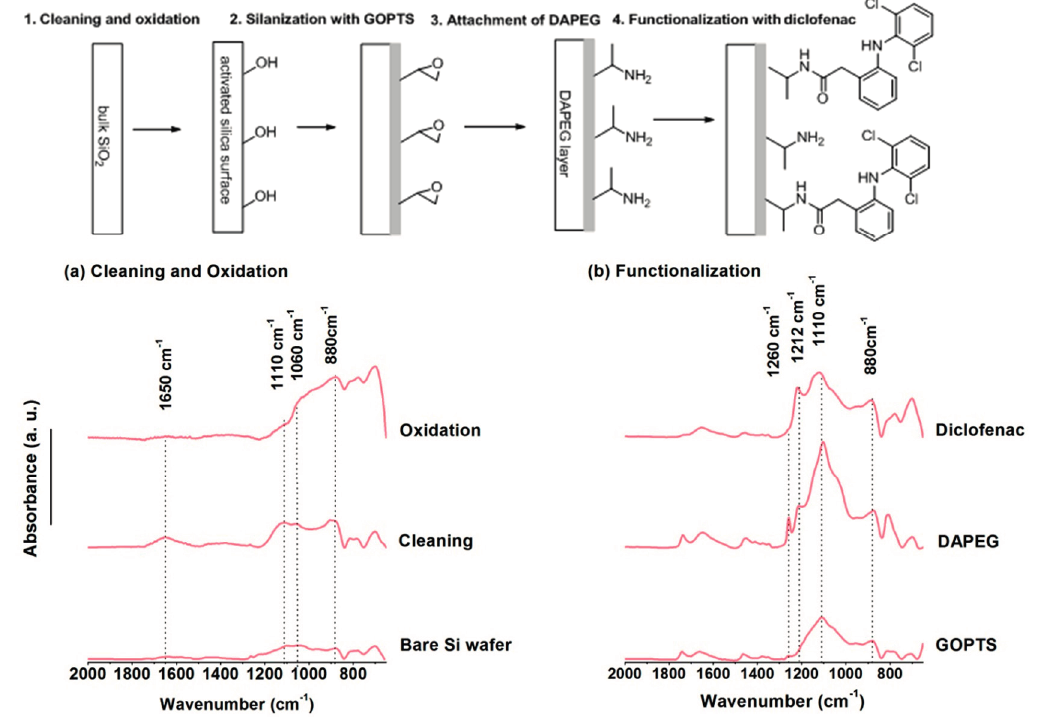
Figure 3. Preparation of a PEG based diclofenac biosensor chip or microarray followed at each step of cleaning and functionalization by Surface IR in Attenuated Total Reflection (ATR) mode, adapted from reference